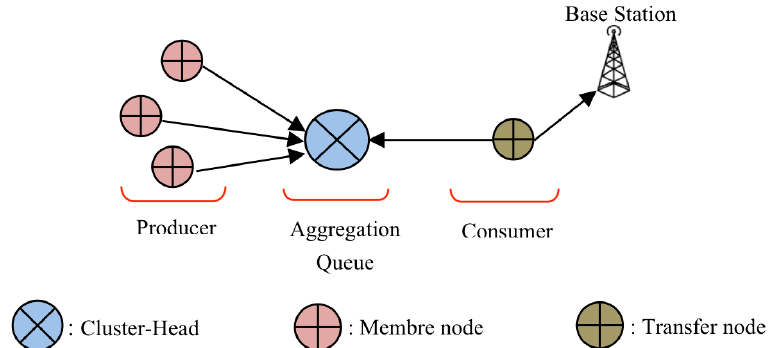
Fig. 1. Producer-consumer pattern apply to cluster